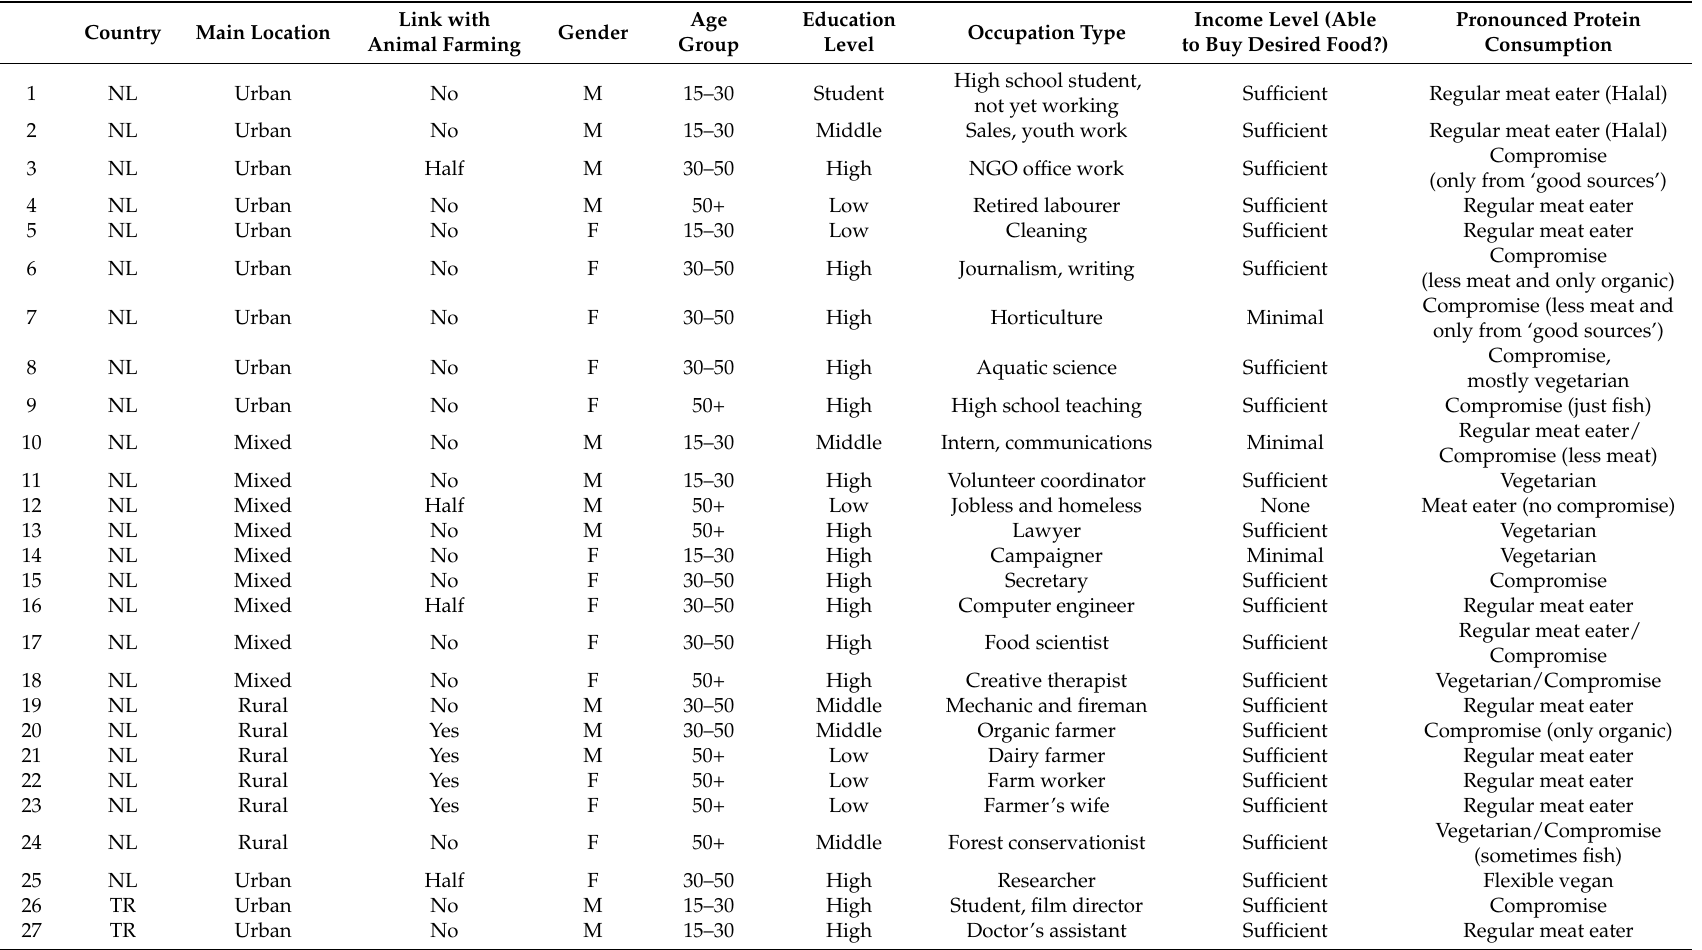
Table A1. Overview of the demographic characteristics of the 50 respondents that were selected for the planned semi-structured in-depth